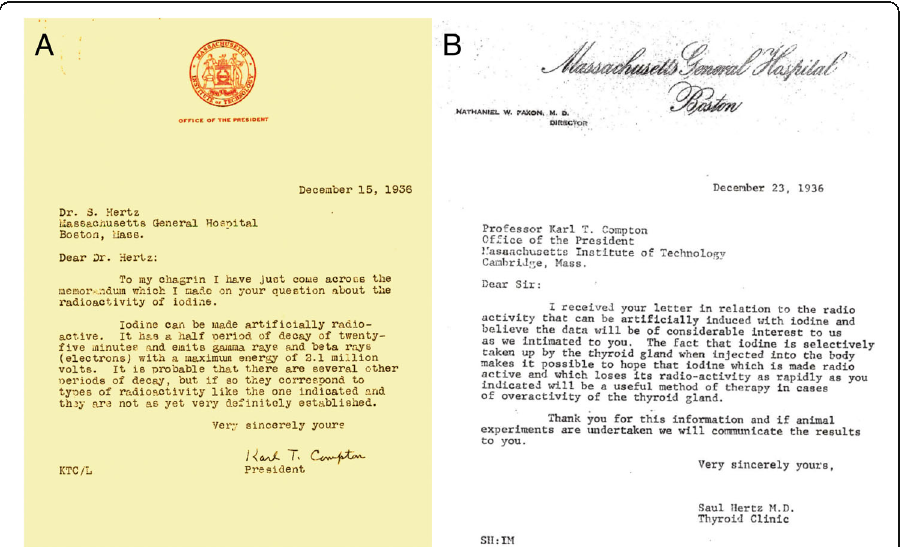
Fig. 1 a Letter from Karl Compton, president of the Massachusetts Institute of Technology, to Dr. Saul Hertz dated December 15, 1936. In the letter, Dr. Compton clearly indicates that the question regarding whether iodine could be made radioactive had been asked by Dr. Hertz. b Response from Dr. Hertz to Dr. Compton dated December 23, 1936. In this response, Dr. Hertz notes that radioactive iodine “ will be a useful method of therapy in cases of the overactive thyroid gland